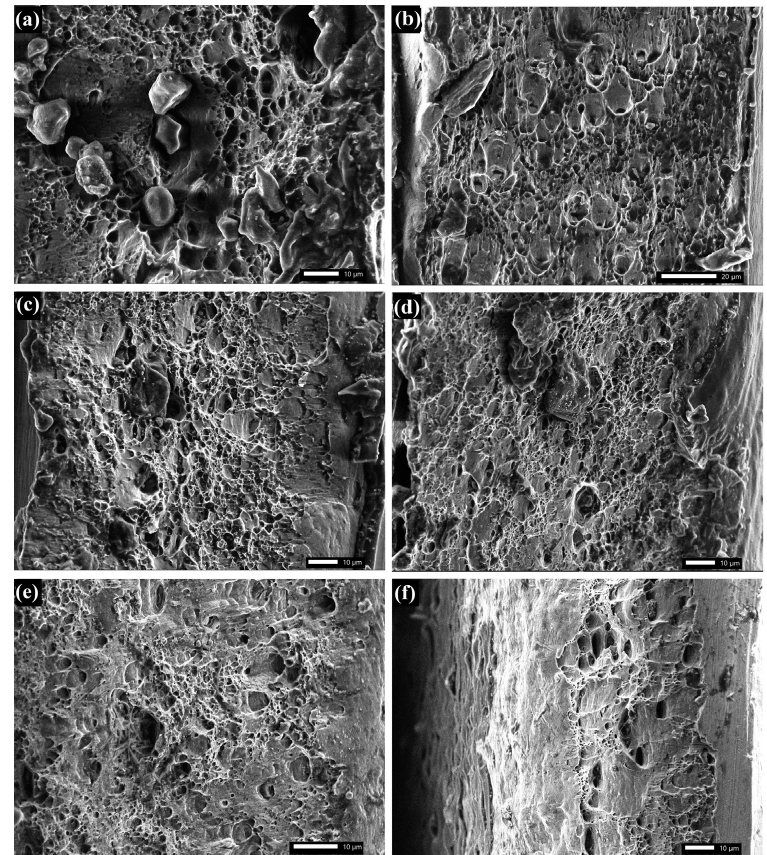
Figure 8. AA 5182 aluminum alloy heated for a period of 10 min. SEM of tensile fracture tests of samples annealed at a) 50 °C, b) 100 °C, c) 150 °C, d) 200 °C, e) 250 °C, f) 300